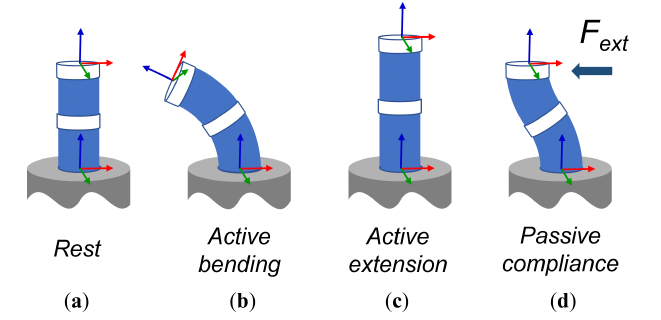
Figure 2. Relevant modes of deformation of the continuum robot module: ( a ) module depiction at rest for comparison, ( b ) module in controlled bending, ( c ) module in controlled extension/contraction, ( d ) module under influence of a radial force applied to the distal end. Arrows in green, red and blue represent base and tip axis x, y and z